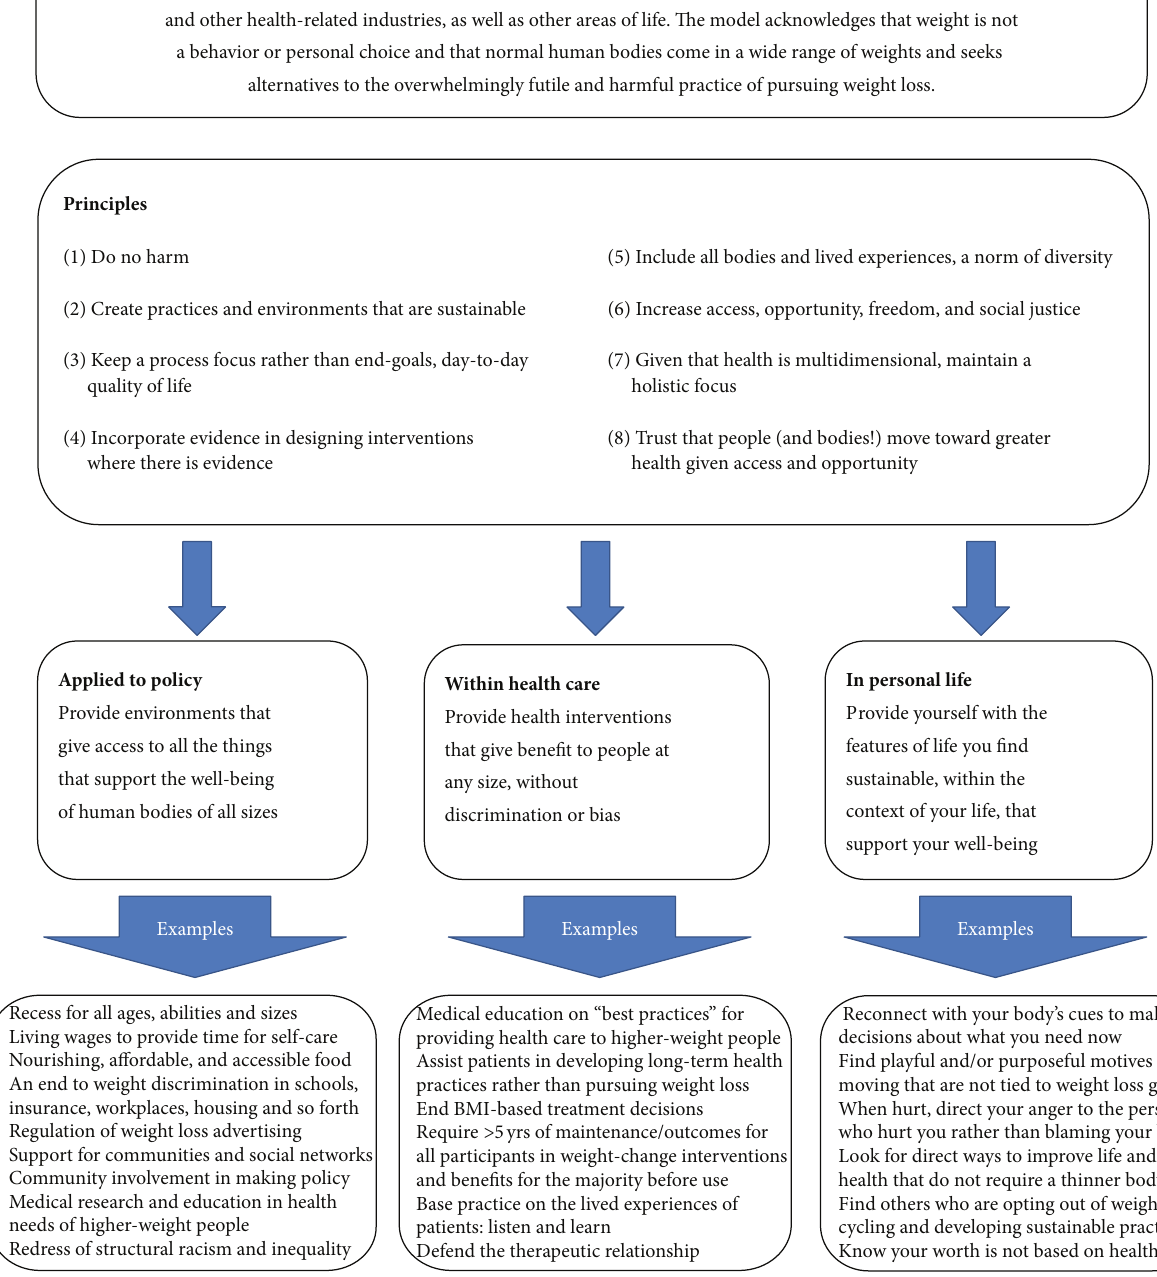
Figure 1: Health at Every Size (HAES): a model using a weight-inclusive